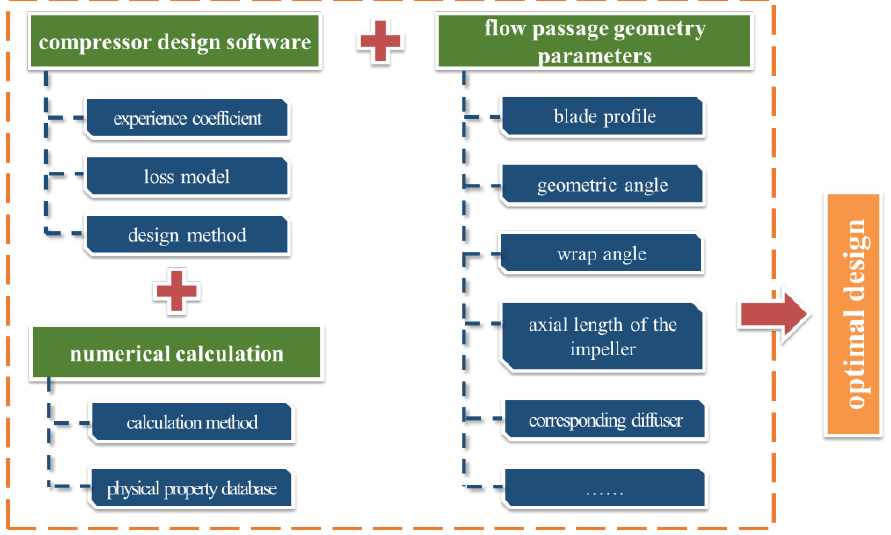
Figure 4. The optimization process.